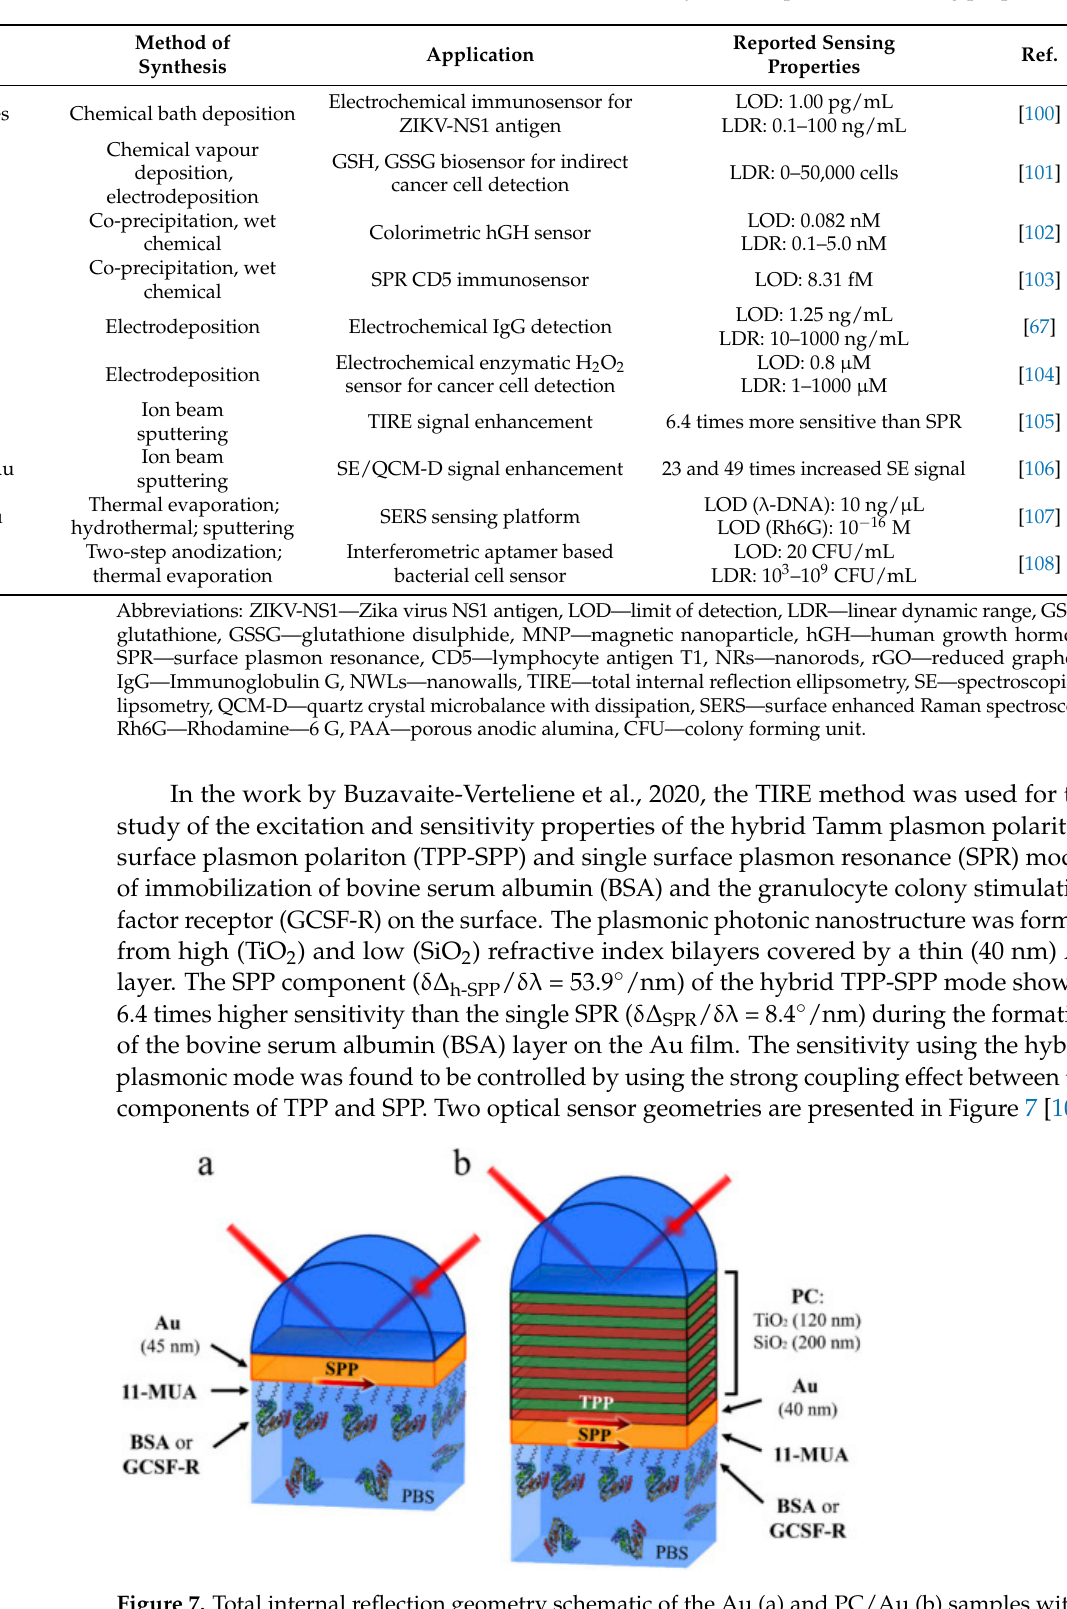
Table 1. Nanostructure formation methods, detected analyte and reported biosensing properties.